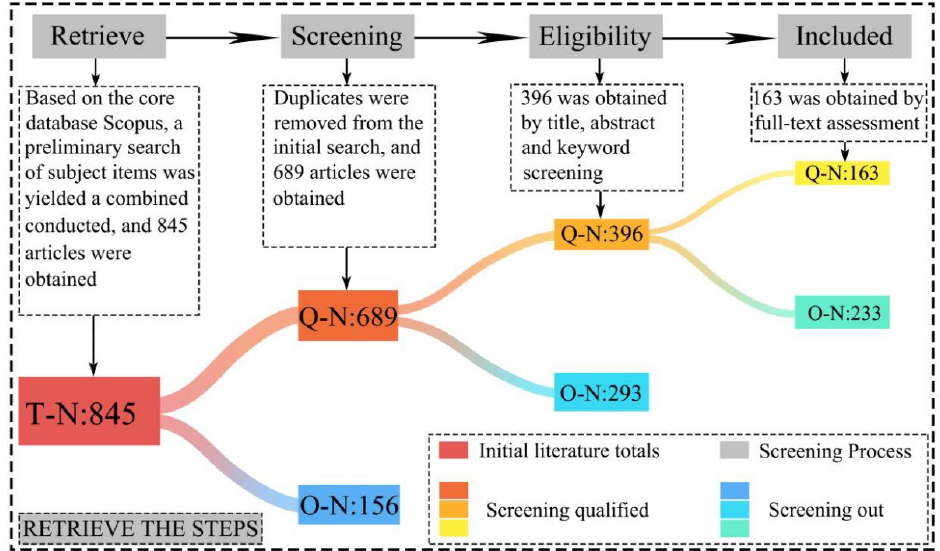
Figure 2. The systematic mapping process of research literature acquisition integrates the four steps of retrieve, screening, eligibility, and inclusion. (T-N, the total number of initial; Q-N, number of screening qualified; O-N, number of screening out).